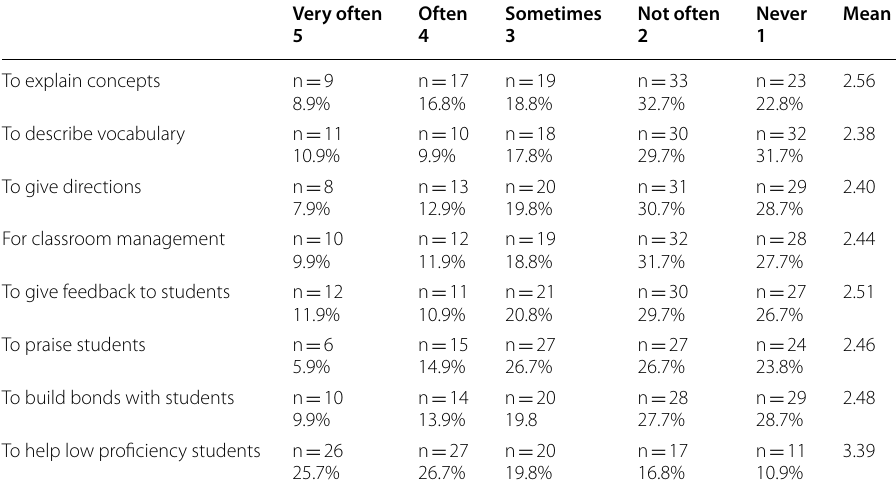
Table 5 Teachers’ self-reported use of their use of students’ native language(s) in the